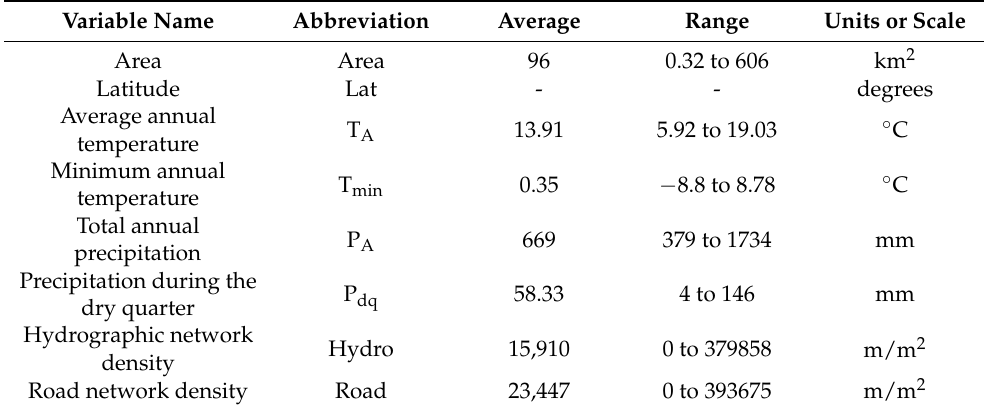
Table 5. Summary of variables used in the generalized linear models as predictor